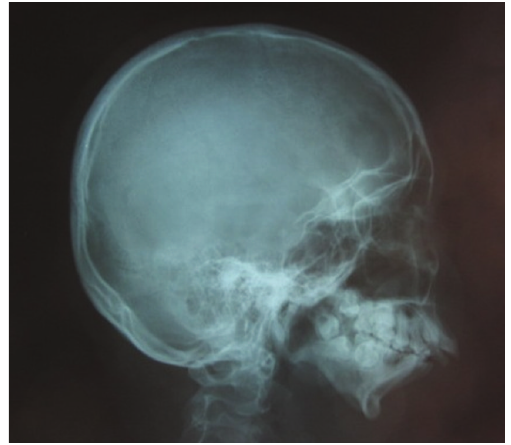
Figure 7: Lateral skull. Radiograph shows severe retruded man- dible.